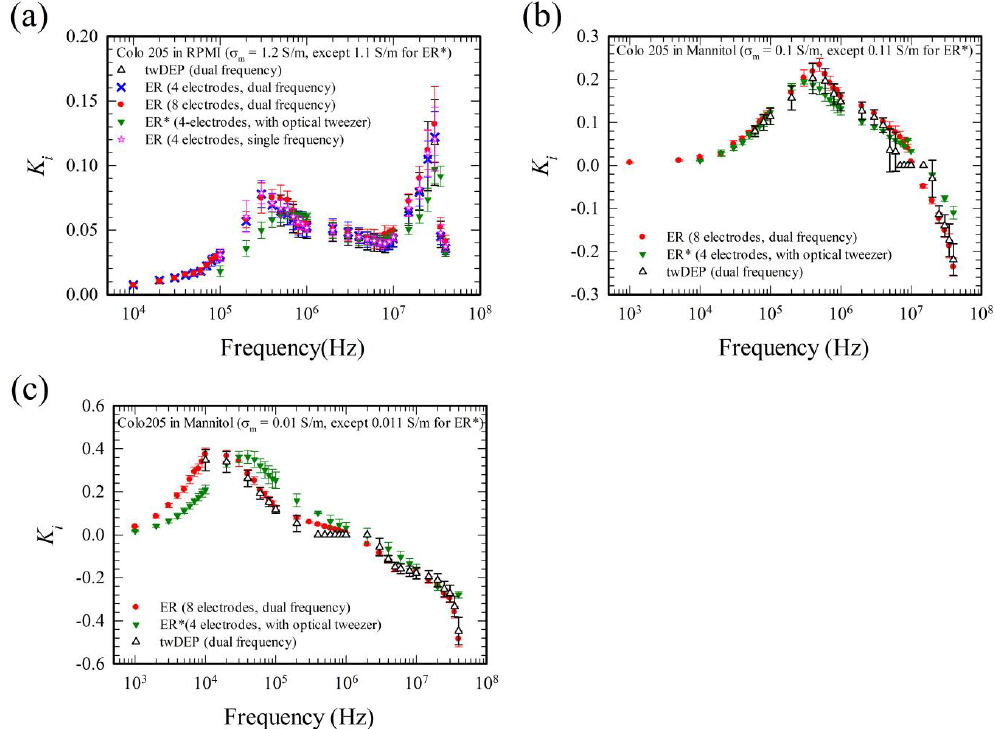
Figure 7. Comparison of the present measurements with experimental results in the literature for Colo205 cells in ( a ) RPMI solution with σ m ≈ 1.2 S / m, ( b ) mannitol solution with σ m ≈ 0.1 S / m, and ( c ) mannitol solution with σ m ≈ 0.01 S / m. ER (4 electrodes, single or dual frequency) and ER (8 electrodes, dual frequency) denote the present experimental results using the four-electrode and the eight-electrode systems, respectively. twDEP (dual frequency) refers to the experimental result in Ref. [11] using twDEP method operated with dual frequency. ER* (4 electrodes, with optical tweezer) refers to the experimental result in Ref. [10] using ER with optical tweezer for particle